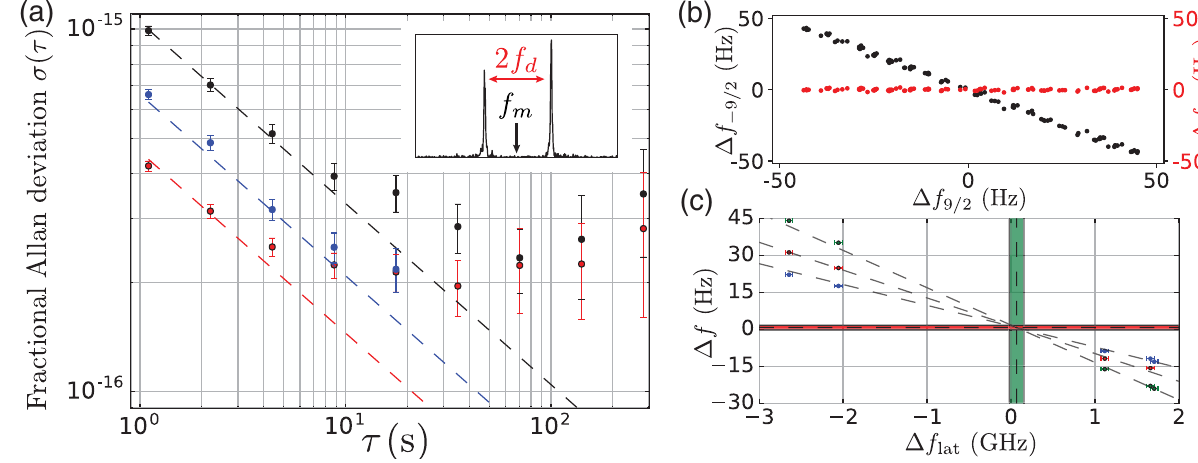
FIG. 3. Stability and accuracy of the superradiant laser. (a) Short-term stability of superradiant light source expressed as fractional Allan deviation σ ð τ Þ . We populate both stretched states and compute the Allan deviation for two quantities: the average frequency of the two lasing transitions f m (black and blue points) and half the difference of the two lasing transition frequencies f d (red points). During a ffiffiffiffiffiffiffi p τ =s longer data set, we measure a short-term fractional instability of σ ð τ Þ ¼ 1 . 04 ð 4 Þ × 10 − 15 = for the average frequency (black dashed ffiffiffiffiffiffiffi p τ =s line) and a value of σ ð τ Þ ¼ 6 . 7 ð 1 Þ × 10 − 16 = for a shorter data set taken under particularly quiet conditions (blue dashed line). (b) Real-time insensitivity to changing magnetic fields is obtained by simultaneously fitting the frequencies of two radiating transitions. Perturbations to the two individual transitions Δ f (cid:3) 9 = 2 (black points) are suppressed to below the half-percent level in the sum frequency Δ f m (red points). (c) Lattice-induced frequency shifts, with the frequency difference between the superradiant laser and an optical lattice clock for different lattice laser detunings and power levels. Different colored points correspond to different lattice depths: U ¼ 1025 , 760, 570 E for green, red, and blue points, respectively, where E is the lattice recoil energy. The horizontal axis shows rec rec Δ f ¼ f − f wm , where f wm is the expected value for the magic wavelength as measured by our wave meter. A simultaneous fit lat lat magic magic (see text) to all data points returns a nominal frequency offset consistent with zero, represented by the horizontal dashed line, with the uncertainty of the fit represented by the red band. The vertical dashed line represents the fit magic wavelength, relative to f wm , with fit magic uncertainty given by the green Fig. 2(b), and compute the Allan deviation for two quantities: the average frequency of the two lasing transitions f m ¼ ð f 9 = 2 þ f − 9 = 2 Þ = 2 (black and blue points), which provides an indication of the stability of our system if used as an optical frequency reference, and half the difference of the two lasing transition frequencies f d ¼ ð f − f Þ = 2 (red points), which provides a means of 9 = 2 − 9 = 2 assessing the fundamental limits of our system. For the black points, σ ð τ Þ ¼ 1 . 04 ð 4 Þ × 10 − 15 = for small τ . Our most favorable measurement of this value (blue ffiffiffiffiffiffiffi p τ =s points) was σ ð τ Þ ¼ 6 . 7 ð 1 Þ × 10 − 16 = , obtained for a different, shorter set of data. This corresponds to a standard deviation of 300 mHz.